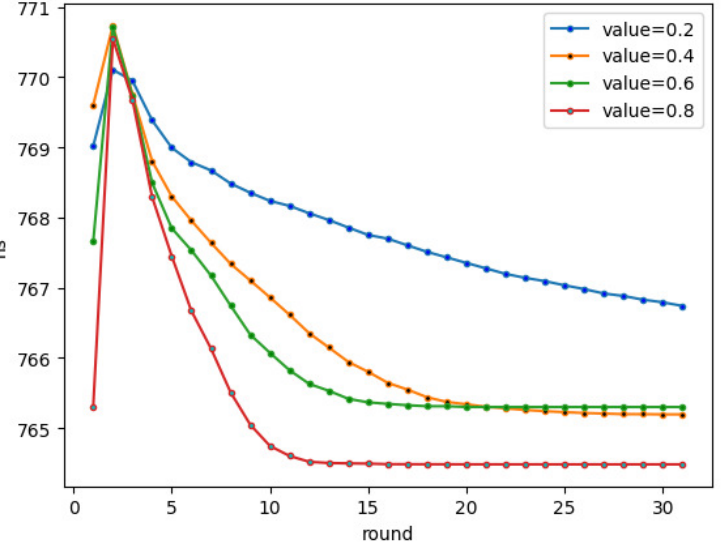
Figure 8. Effect of the parameter value on the global structural balance: h s changes with